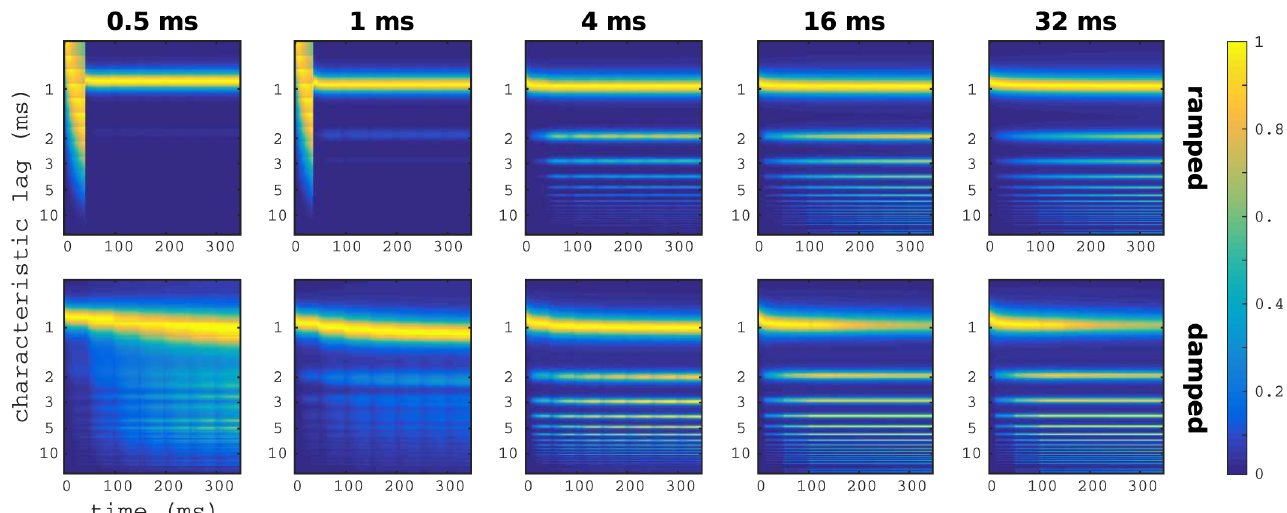
Fig 7. GPM raw output for the ramped and damped stimuli. Heat maps show the evolution in time ( x -axis) of the activity of the different ensembles ( y -axis) in the third layer of the GPM model for ramped (top) and damped (bottom) sinusoids with different T 1/2 . In all cases, after a small period of instability, there is a maximum centred in the ensemble characterized by δ t = 1ms, the frequency of the carrier sinusoid. Qualitative differences are noticeable between the output of ramped and damped stimuli, and also between stimuli with different envelope time